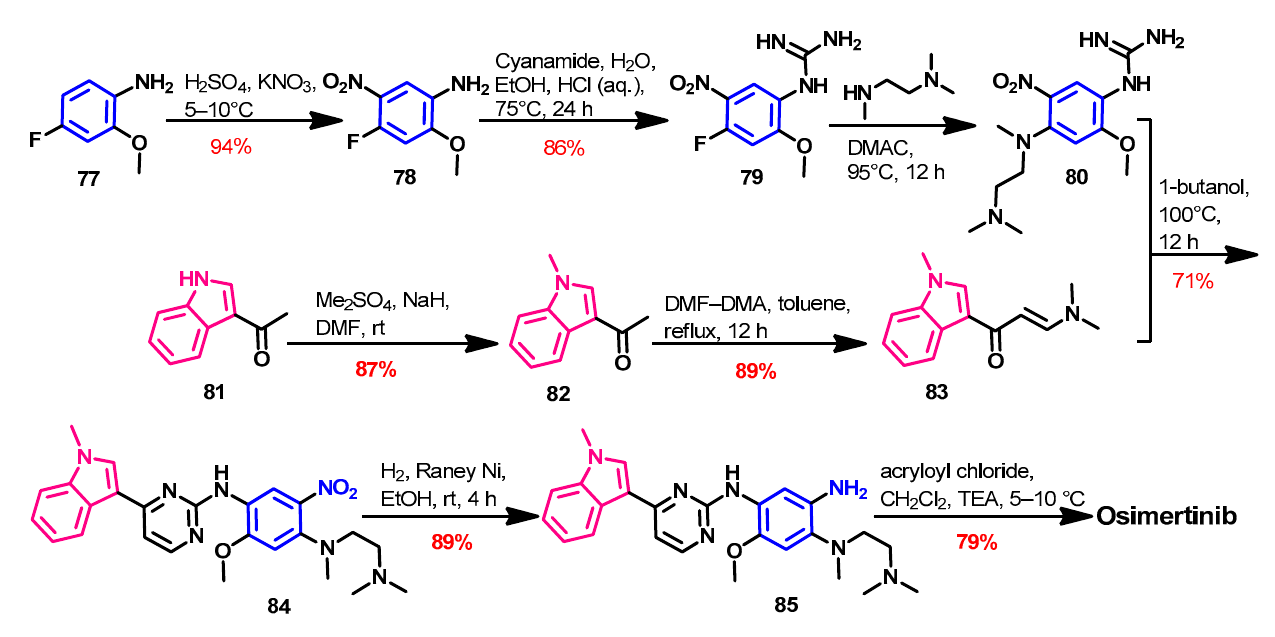
Figure 52. Kinase inhibitory activity (IC 50 values) of osimertinib.